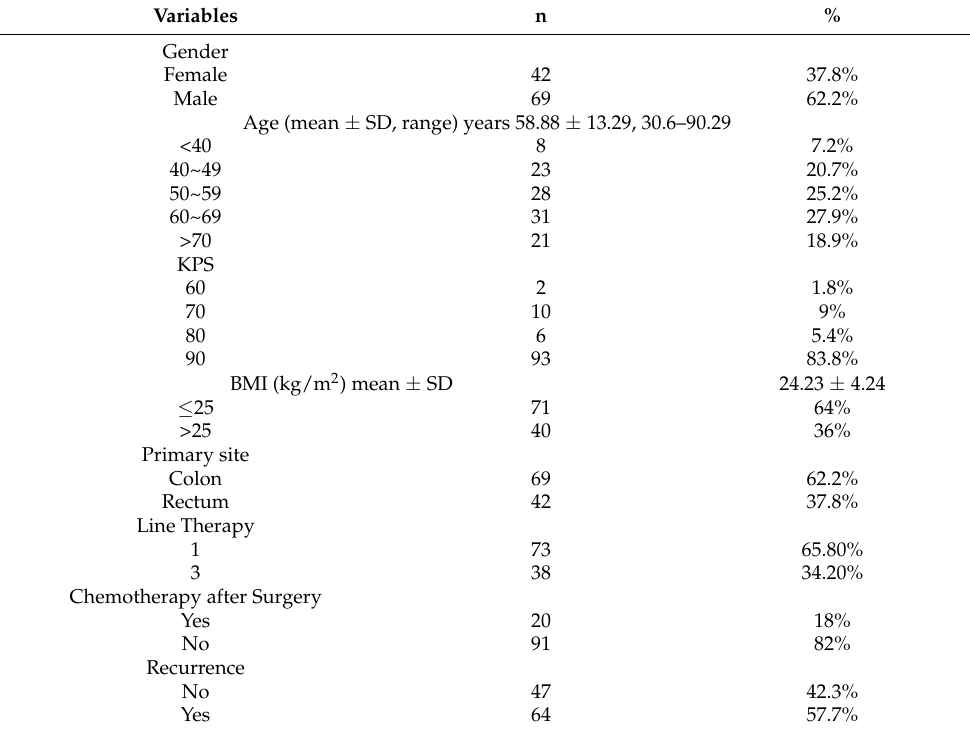
Table 1. Characteristics of patients at baseline (N =